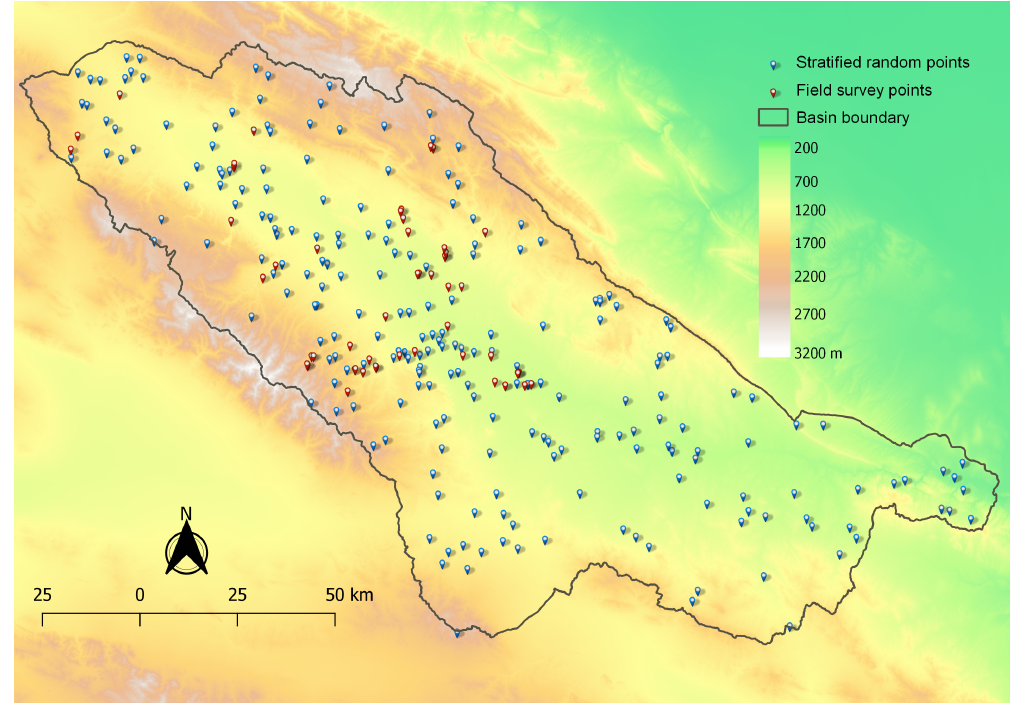
Figure 5. Validation points collected from field (red) and stratified random points (blue) used for accuracy